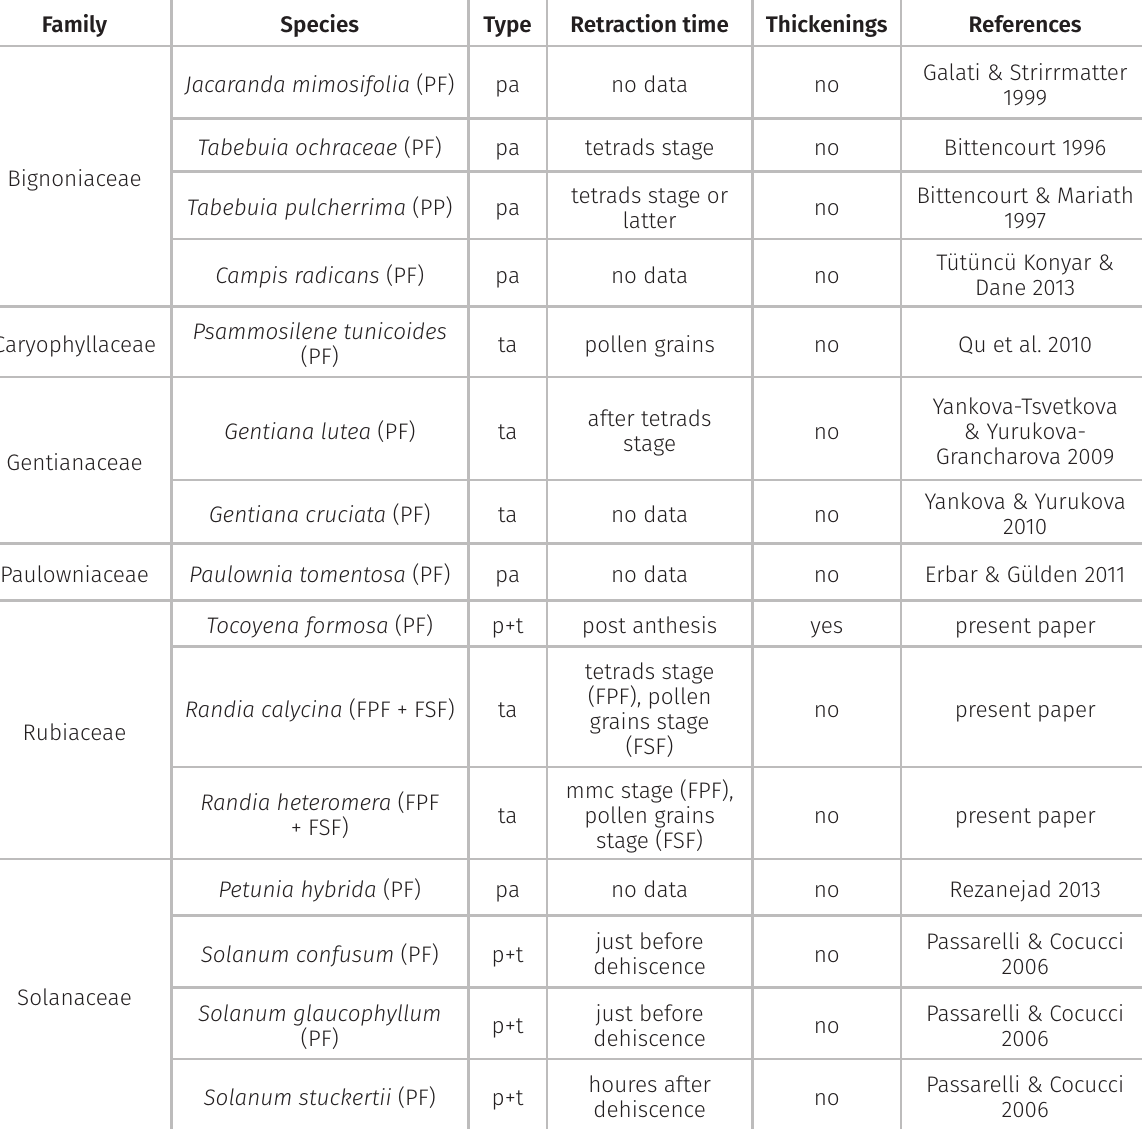
Table III. Species with placentoid in the anther, type, duration and bibliographic citation. Abbreviations: pa: parenchymatic placentoid; ta: tapetal plancetoid; p+t: parenchymatic and tapetal